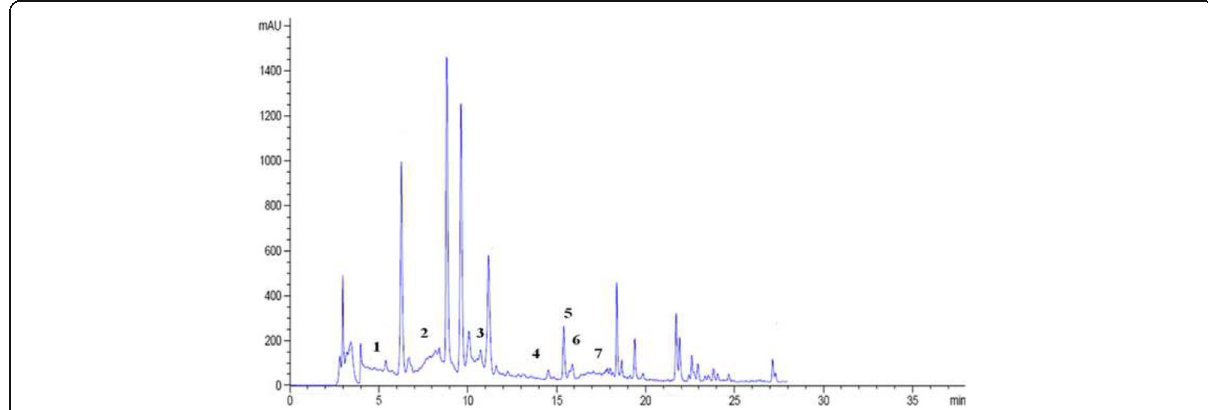
Fig. 2 HPLC chromatogram of ethanol extract from leaves of Cynara scolymus . Peaks: 1, Hydroxytyrosol; 2, Verbascosie; 3, Apigenin-7-glucoside; 4, Oleuropein; 5, Quercetin; 6, Pinoresinol; 7,